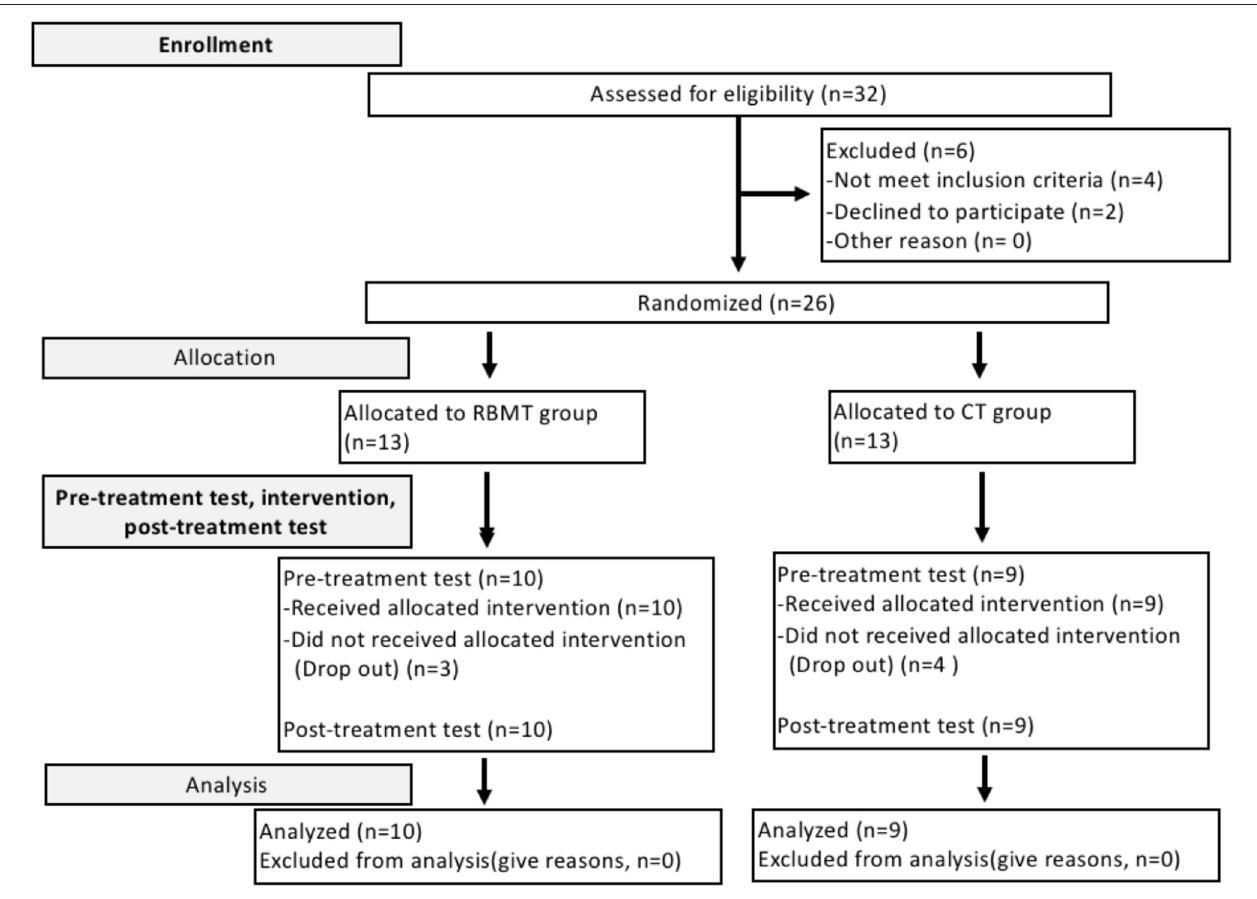
FIGURE 2 | The CONSORT